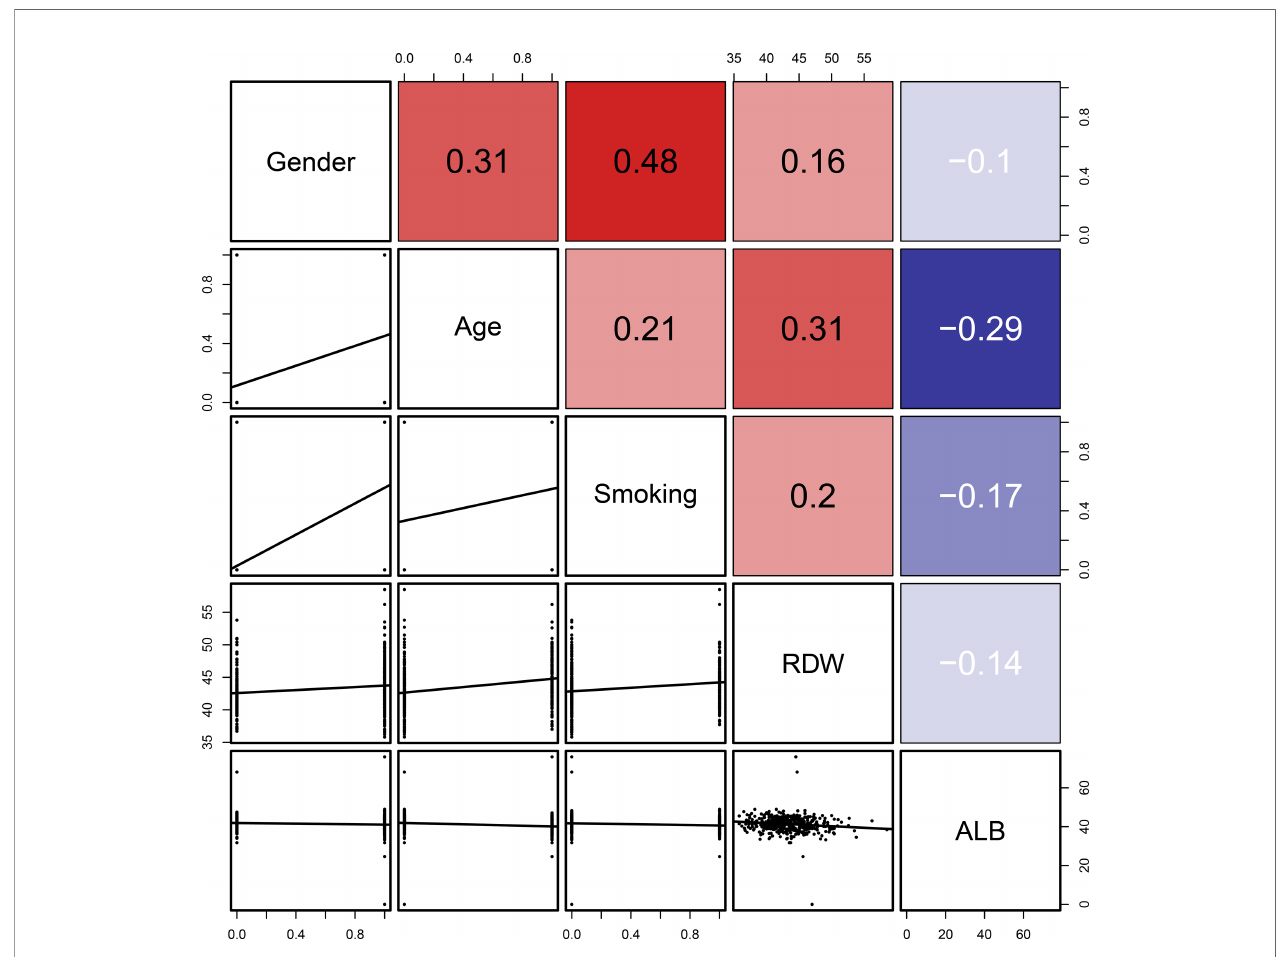
FIGURE 5 | Linear correlation analysis of the fi ve indicators (age, sex, smoking history, RDW, and ALB). The number in the right of the plot was the correlation coef fi